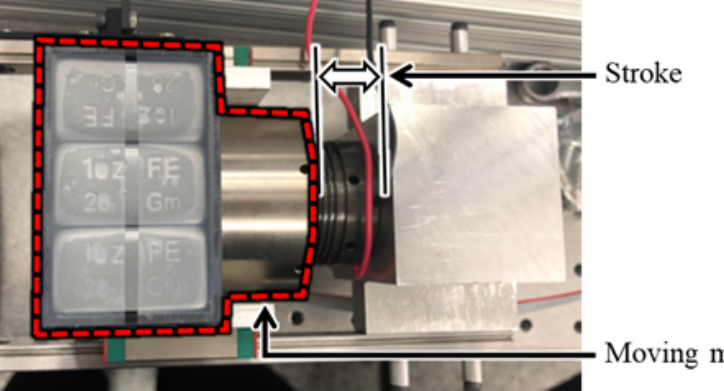
Figure 11. The limited stroke of the vibration control